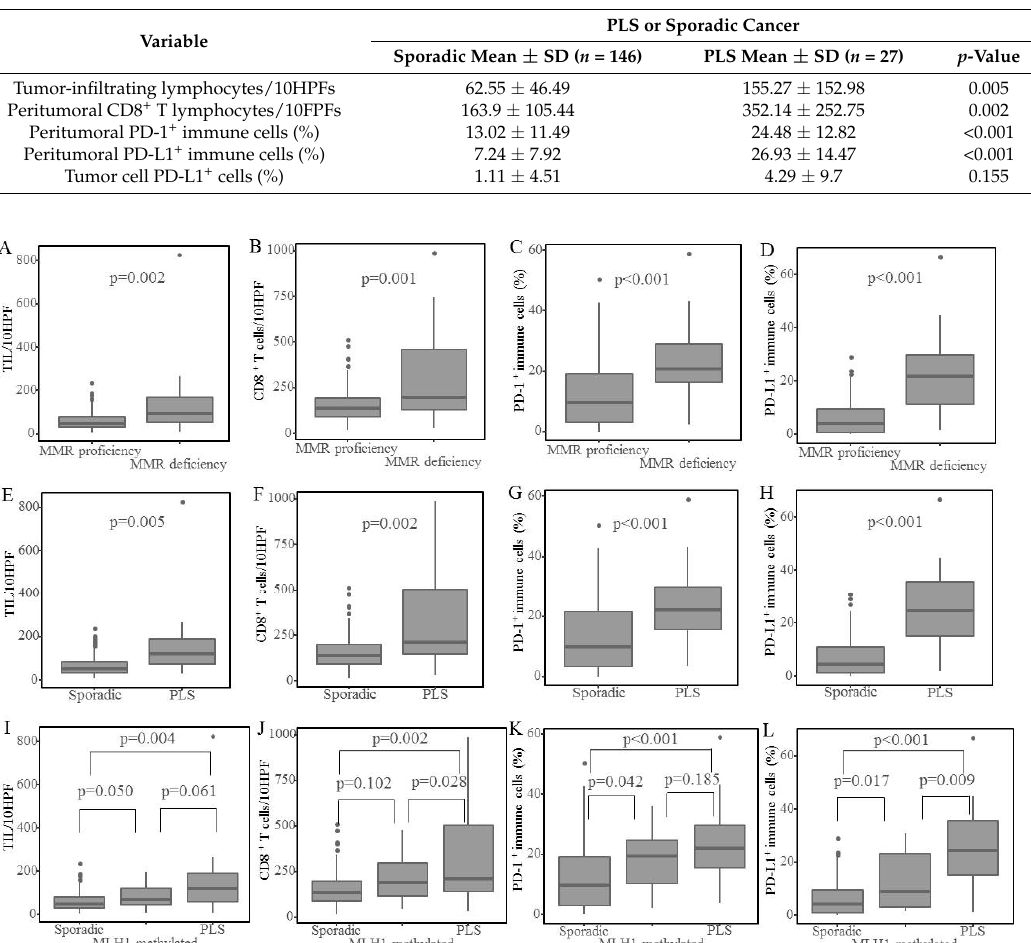
Figure 2. Peritumoral immune marker expression. ( A – D ) Immune marker expression in MMR proficient vs MMR deficient tumors, including ( A ) TIL, ( B ) CD8 + T lymphocytes, ( C ) peritumoral PD-1 + immune cells, and ( D ) peritumoral PD-L1 + immune cells. ( E , F ) Immune marker expression in sporadic cancer vs PLS cases, including ( E ) TIL, ( F ) CD8 + T lymphocytes, ( G ) peritumoral PD-1 + immune cells, and ( H ) peritumoral PD-L1 + immune cells. ( I – K ) Immune marker expression in sporadic vs MLH1 methylated vs PLS cases, including ( I ) TIL, ( J ) CD8 + T lymphocytes, ( K ) peritumoral PD-1 + immune cells, and ( L ) peritumoral PD-L1 + immune cells. The horizontal line in each box shows the median, and the top and bottom boundary lines of the box show the 75th and 25th percentiles, respectively. The vertical lines above and below the boxes show the maximum and minimum observations within 1.5 IQR (interquartile range) of the upper and lower quartile. The points beyond the vertical line are outliers beyond the 1.5 IQR of the upper and lower quartile.